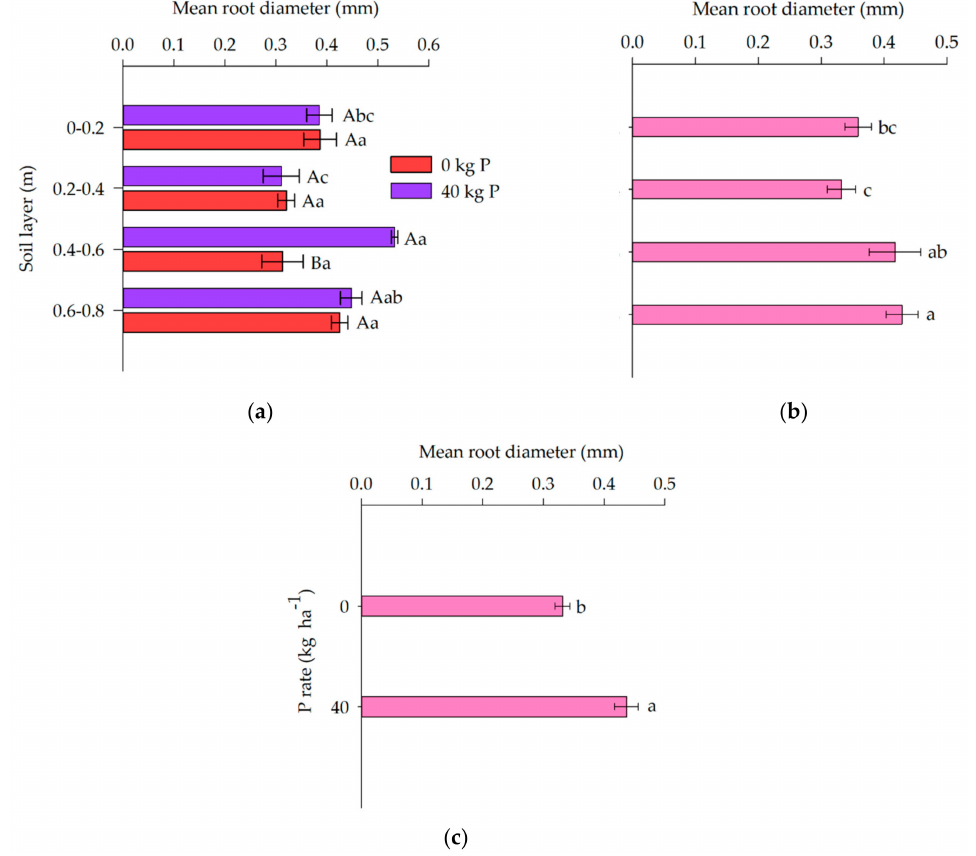
Figure 6. Mean diameter of living roots (mm) of H. heptaphyllus plants subjected to applications of 0 and 40 kg P ha − 1 as observed in 0–0.2 m, 0.2–0.4 m, 0.4–0.6 m and 0.6–0.8 m soil layers at 18 ( a ) and 36 months after transplant (MAT) ( b , c ). ( a ) The uppercase letters compare P rate considering the same soil layer, while lowercase letters compare soil layers based on the Tukey test ( p < 0.05), since the interaction was significant at 5% based on two-way analysis of variance. ( b ) depicts the adjusted bars with mean values at soil layers at 36 MAT compared based on Tukey’s test ( p < 0.05) without considering the P rate, since the interaction was not significant at 5% based on two-way analysis of variance. ( c ) depicts the adjusted bars with mean values of the P rate at 36 MAT compared based on Tukey’s test ( p < 0.05) without considering soil layers, since the interaction was not significant at 5% based on two-way analysis of variance. Horizontal bars represent the standard error of three